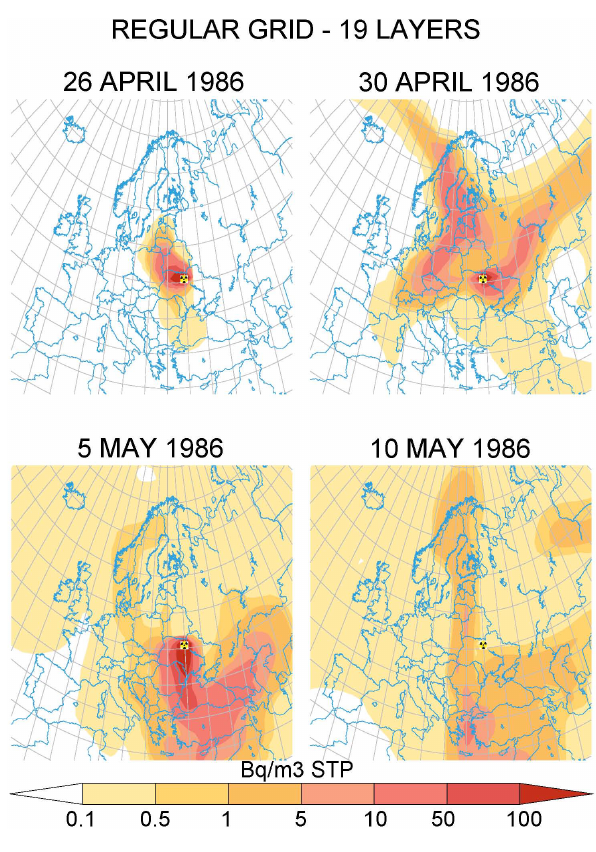
Fig. 3. Daily mean surface 137 Cs activity concentrations (in Bqm − 3 STP) from the Chernobyl accident. Model with regular grid and 19 vertical levels and injection at the real emission height (Ta- ble 1) (RG19L). The figures show the situation during the first day (26 April 1986), at the end of April (30 April 1986), the last day of the emissions (5 May 1986) and on 10 May 1986.